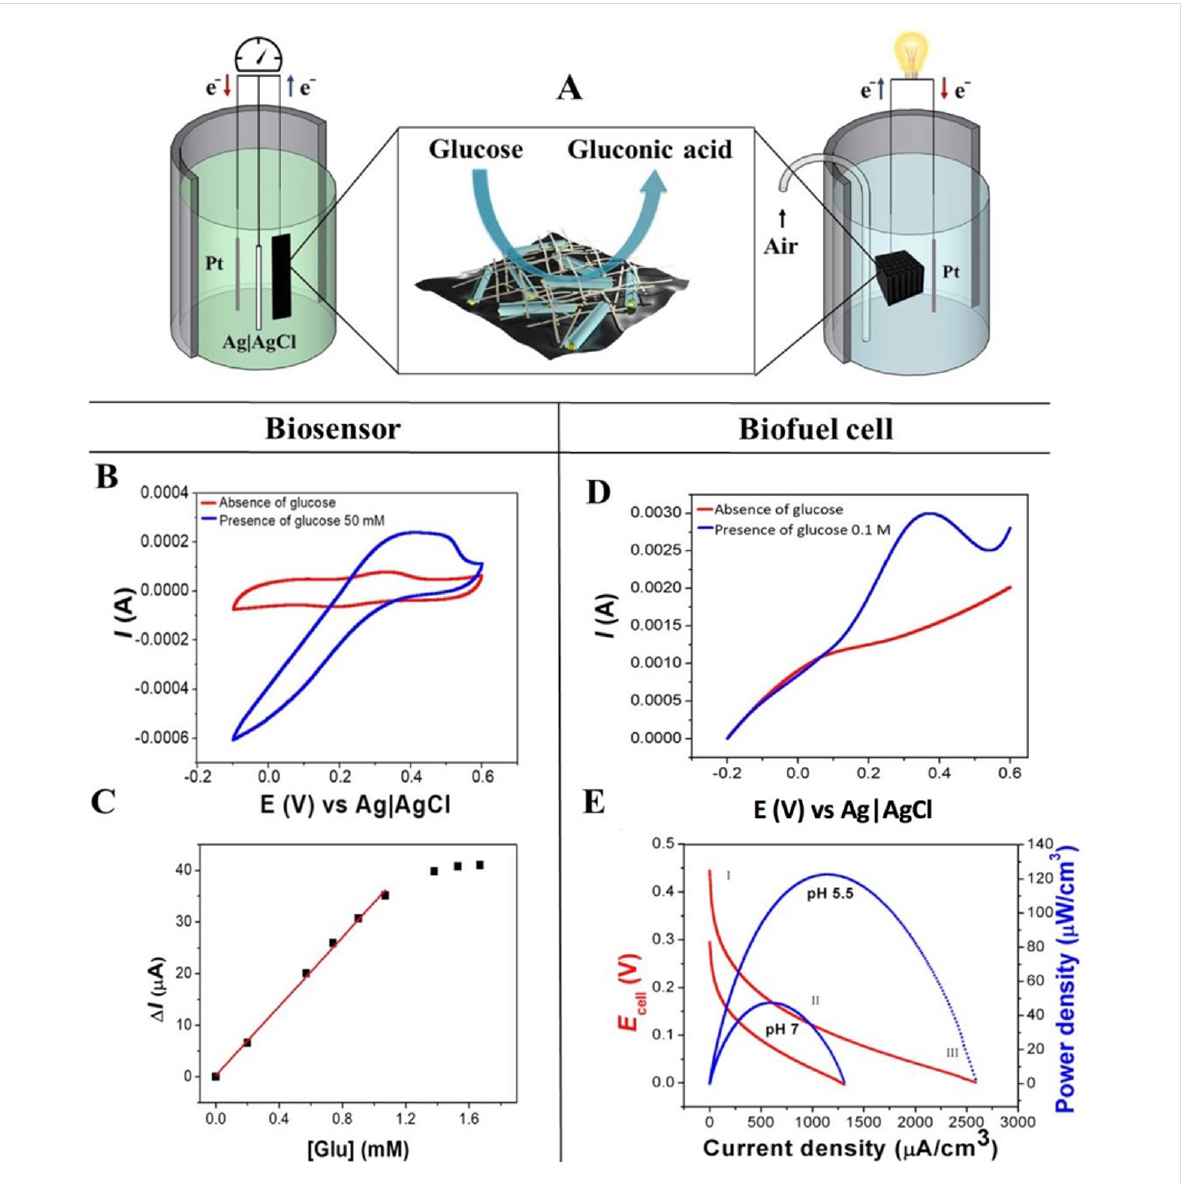
Figure 5: A) Scheme of an EBC (left) and a biosensor (right) with the electrode microstructure and biocatalytic oxidation of glucose at the bioactive nanocomposite interface. B) Effect of glucose on the Film-GOx sample in CV measurement in PBS, pH 7 and 0.1 mM of potassium ferricyanide at a scan rate of 5 mV·s − 1 . C) Sensor response as a function of the glucose concentration. The red line is a linear fit. Δ I = steady-state current at 0.45 V. D) LSV measurement of Foam-GOx immersed in PBS at pH 7 and in the presence of 0.1 M glucose in PBS at the same pH vaue. E) Polarization curve obtained by LSV measurements at a scan rate of 1 mV·s − 1 . The medium is PBS with 1 M glucose at pH 7 and pH